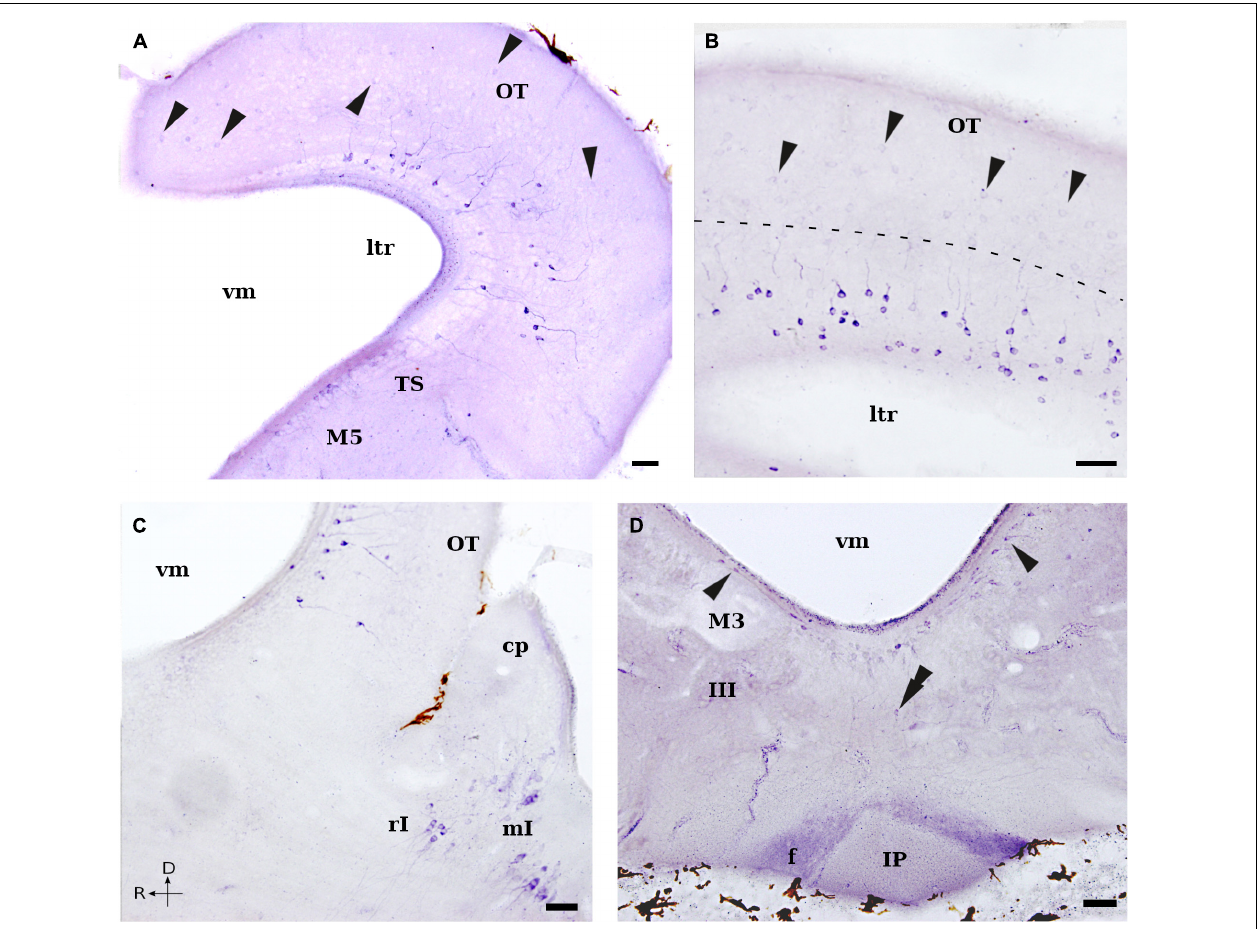
FIGURE 5 | Photomicrographs showing NADPH-d positive cells and fibers in the mesencephalon and isthmic region of L. fluviatilis . (A) Transverse section showing strong NADPH-d positive cells in the deeper layers of the optic tectum (OT) and weaker stained cells (arrowheads) in the superficial layers. Note also the presence of several subependymal cells in the torus semicircularis (TS), as well as a few in the nucleus M5 of Schöber (M5). (B) Transverse section through the caudalmost optic tectum (OT) showing the morphology and distribution of the two types of cells labeled in this structure, separated by a dashed line (arrowheads point to weaker stained superficial cells). (C) Sagittal section showing NADPH-d labeled cells in the caudal optic tectum (OT), as well as in the isthmic region: rostral isthmic nucleus (rI) and medial isthmic nucleus (mI). (D) Transverse section showing NADPH-d positive periventricular cells in the ventral mesencephalic tegmentum (arrowheads). Note the presence of a ventral displaced labeled cell (double arrowhead). Abundant labeled fibers of the fasciculus retroflexus (f) enter the rostral part of the interpeduncular nucleus (IP). Medial and rostral directions are oriented to the left in transverse and sagittal sections, respectively. For abbreviations, see list. Scale bar = 25 µ